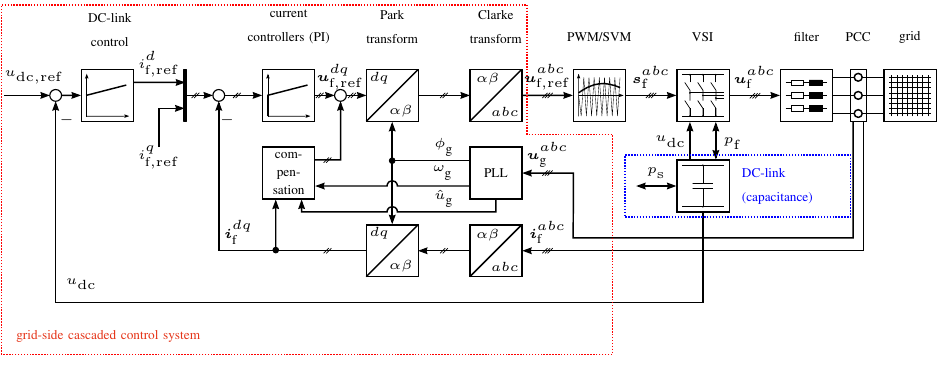
Figure 8. Grid-side cascaded control